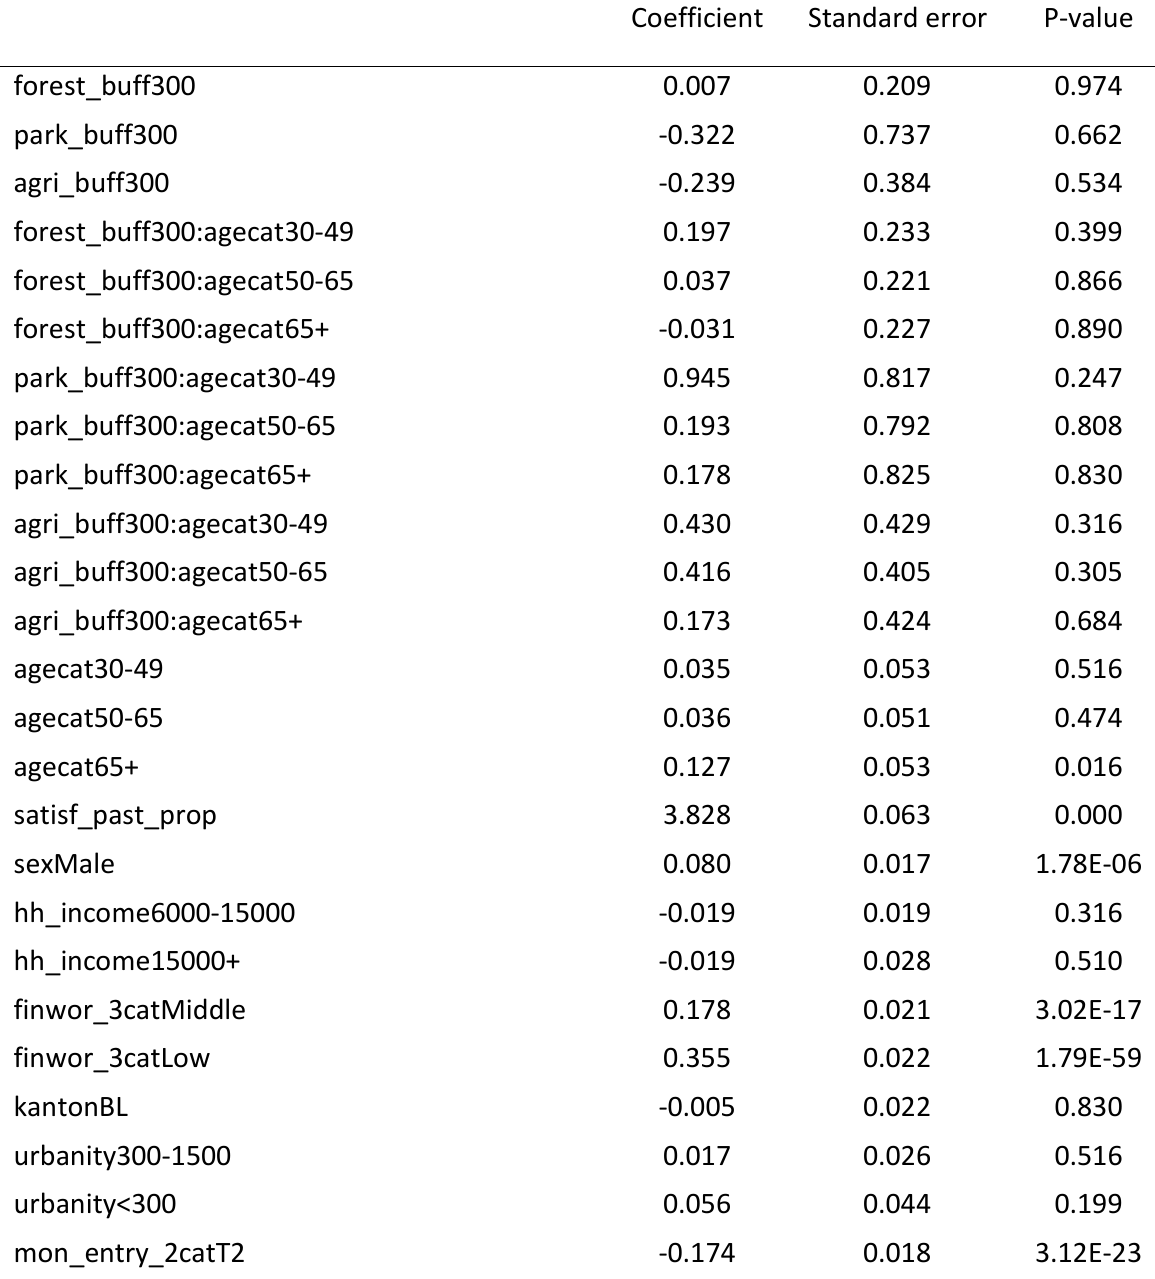
Table S2 . Results from Beta regression of life satisfaction on land use variables (a) by age categories, (b) by household income, (c) by financial worries, adjusted for life satisfaction in the past, age categories, sex, household income, financial worries, canton, degree of urbanisation, and month of entry (a) Moderation by age categories (likelihood ratio test p-value =